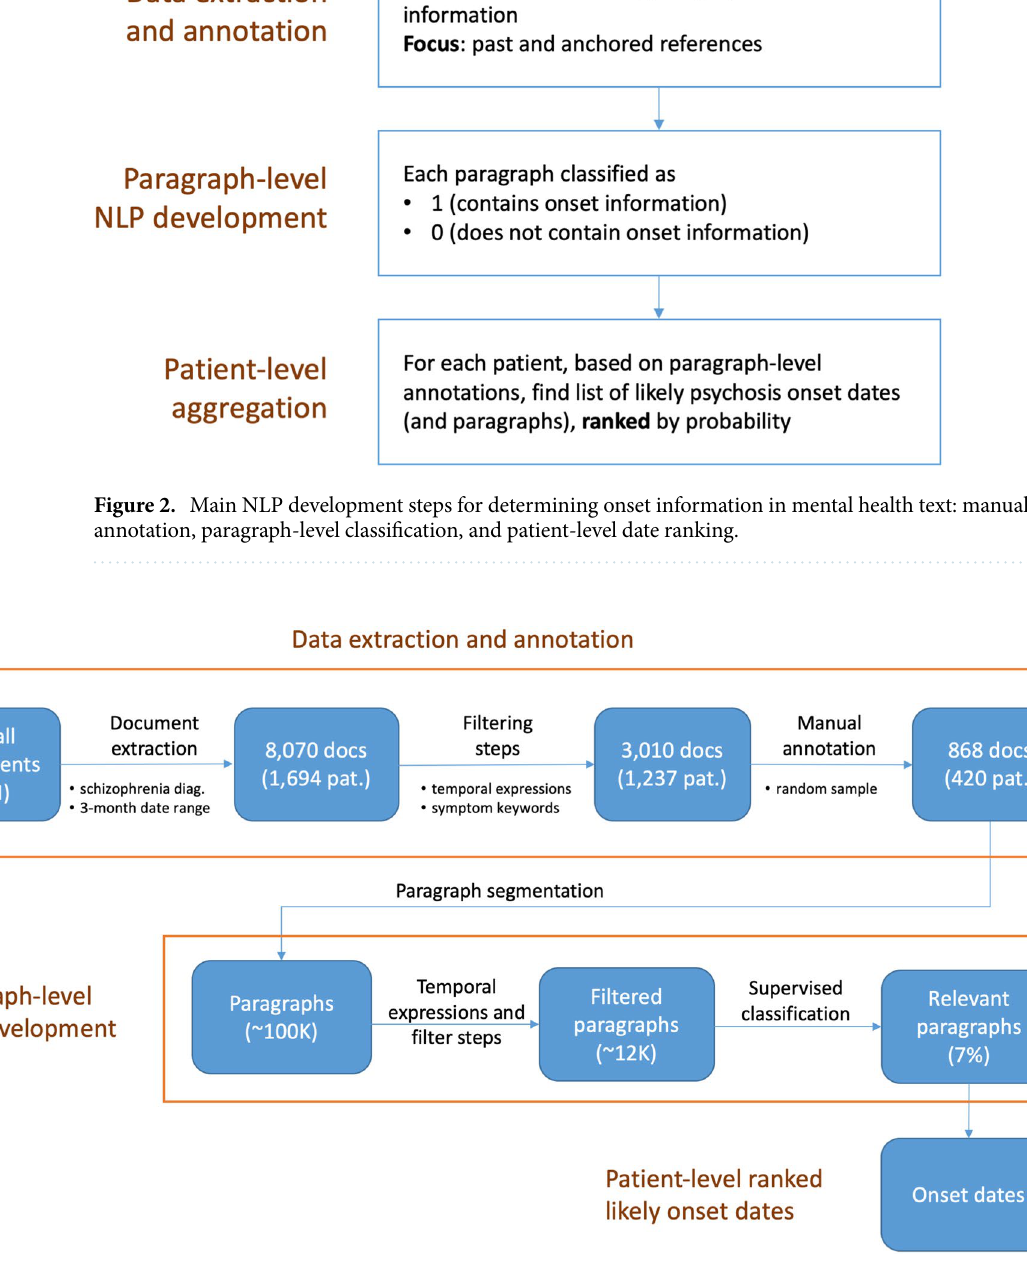
Figure 3. Data annotation and system development. Relevant documents were extracted and manually annotated for psychosis onset information. A paragraph classification model was developed on annotated data, with final aggregation on a patient